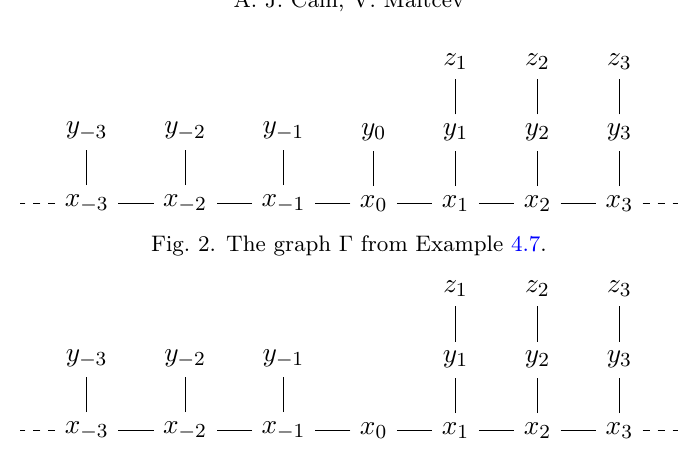
Fig. 3. The cofinite subgraph ∆ of the graph Γ from Example